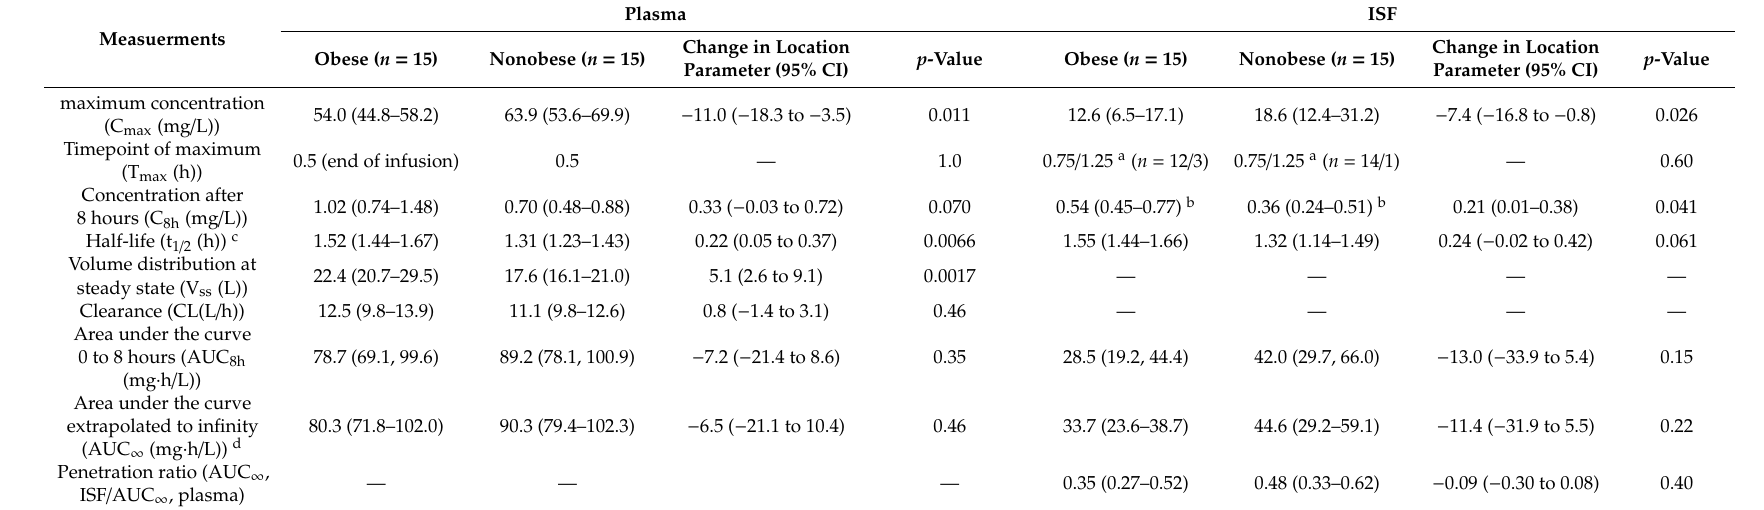
Table 2. Pharmacokinetic